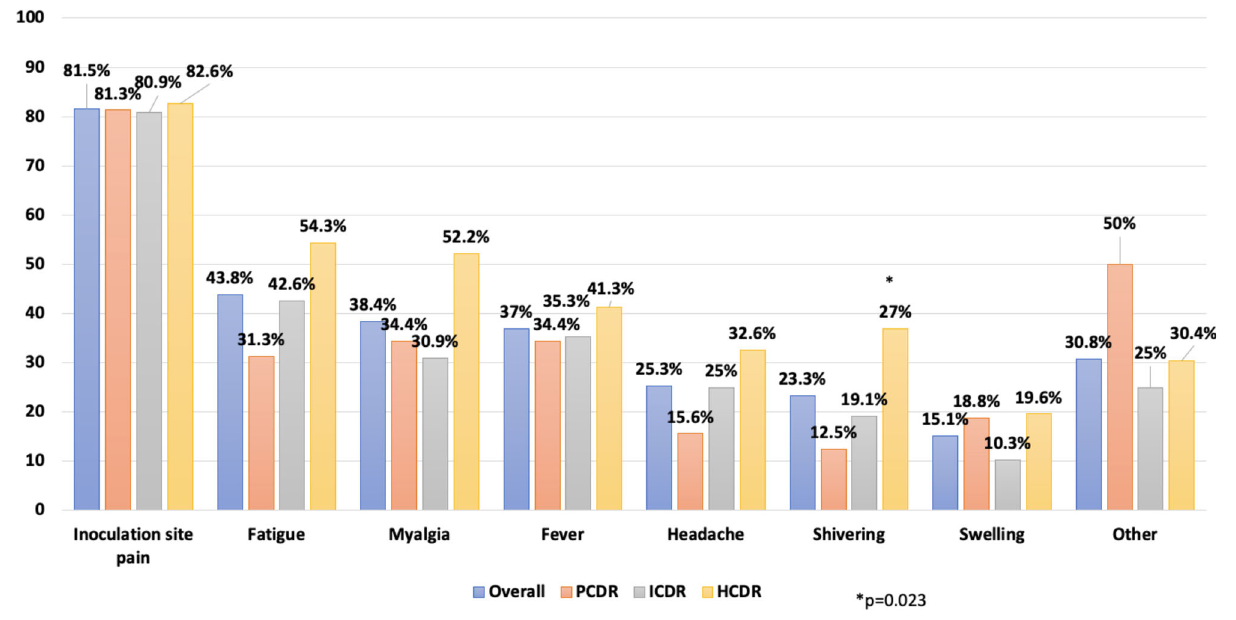
Fig. 5 | Overall self-reported solicited local and systemic reactions in days 0 – 7 aftervaccinationwiththirddose by CD4 count. PCDRLow CD4count recovery,